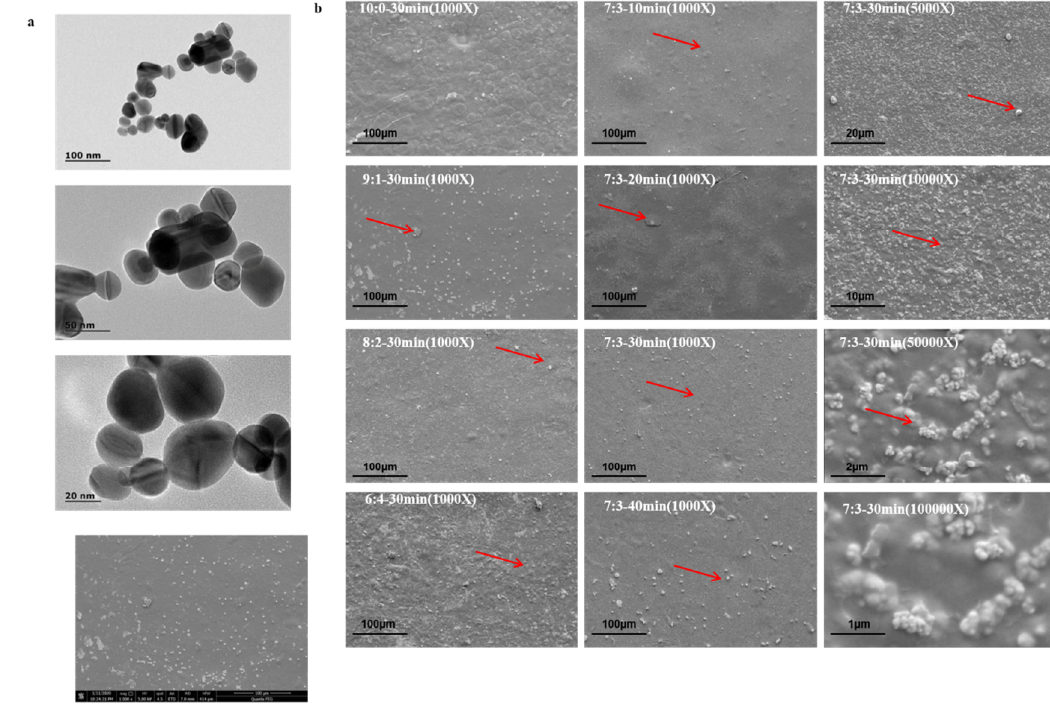
Figure 4. ( a ) TEM of AgNPs; ( b ) SEM images of SA/AgNPs/APP composite film with different ultrasound time, different addition ratio and different magnification .